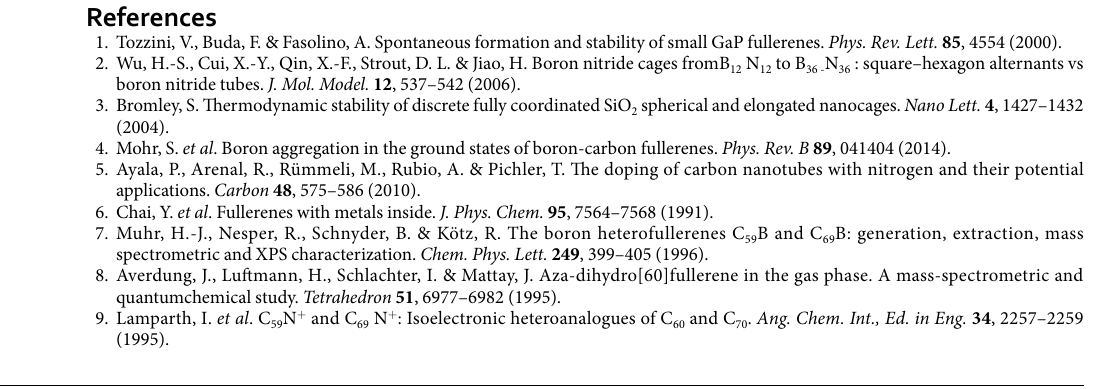
6 Scientific REPORTS | 7: 7618 | DOI:10.1038/s41598-017-06877-7